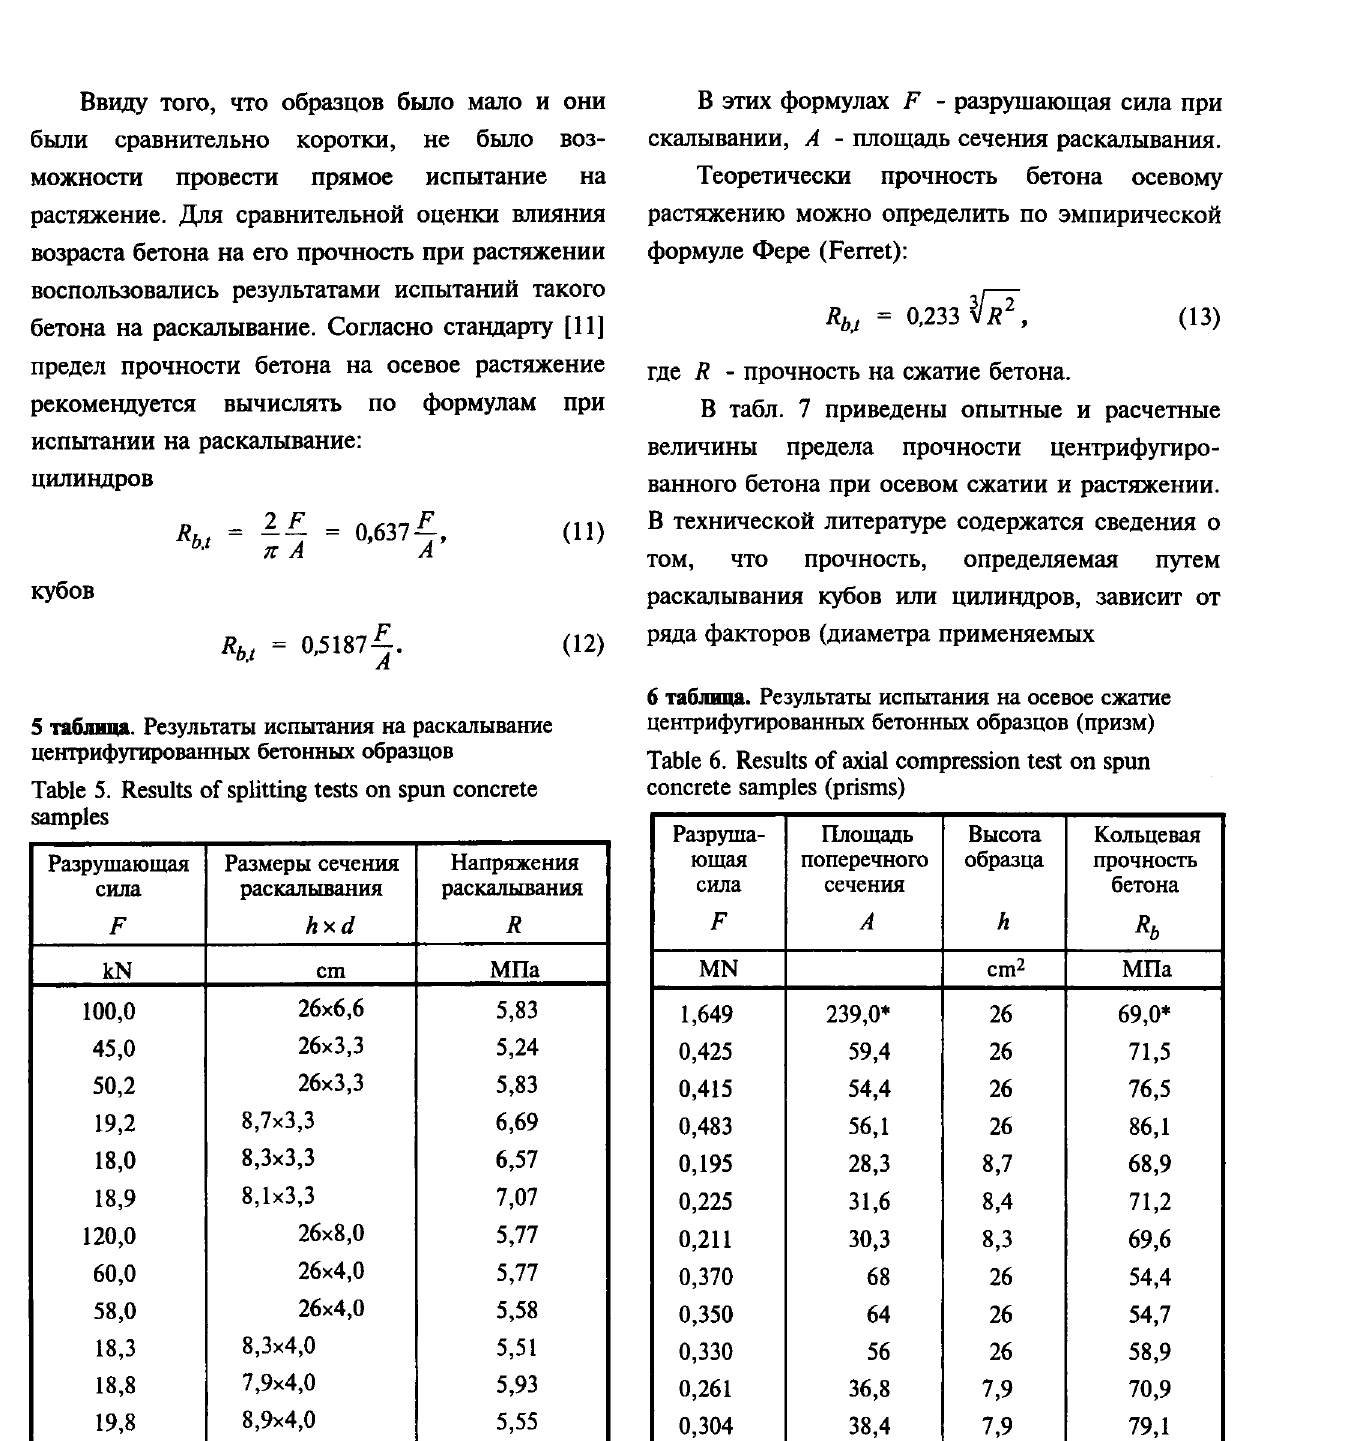
Table 5. Results of splitting tests on spun concrete